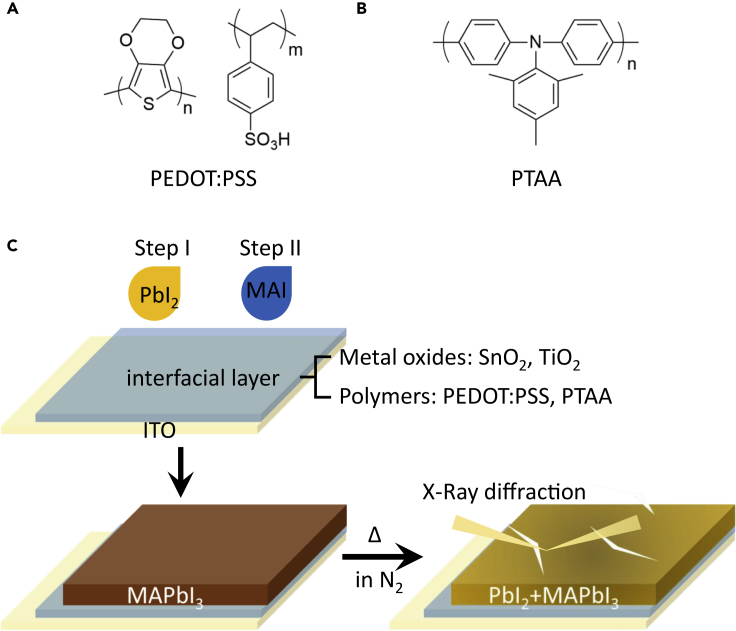
Molecular Structures and Sample Characterization(A and B) The molecular structures of PEDOT:PSS (A) and PTAA (B).(C) Diagram of MAPbI3 perovskite preparation on different interfacial layers and their thermal aging testing.